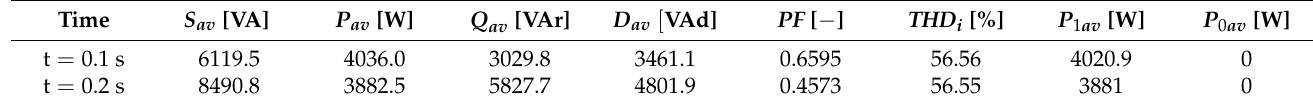
Table 28. Simulation results before and after the change (at steady